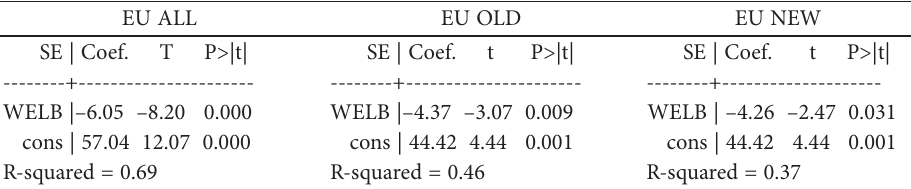
Table 4. Linear regression between SE and WELB EU ALL EU